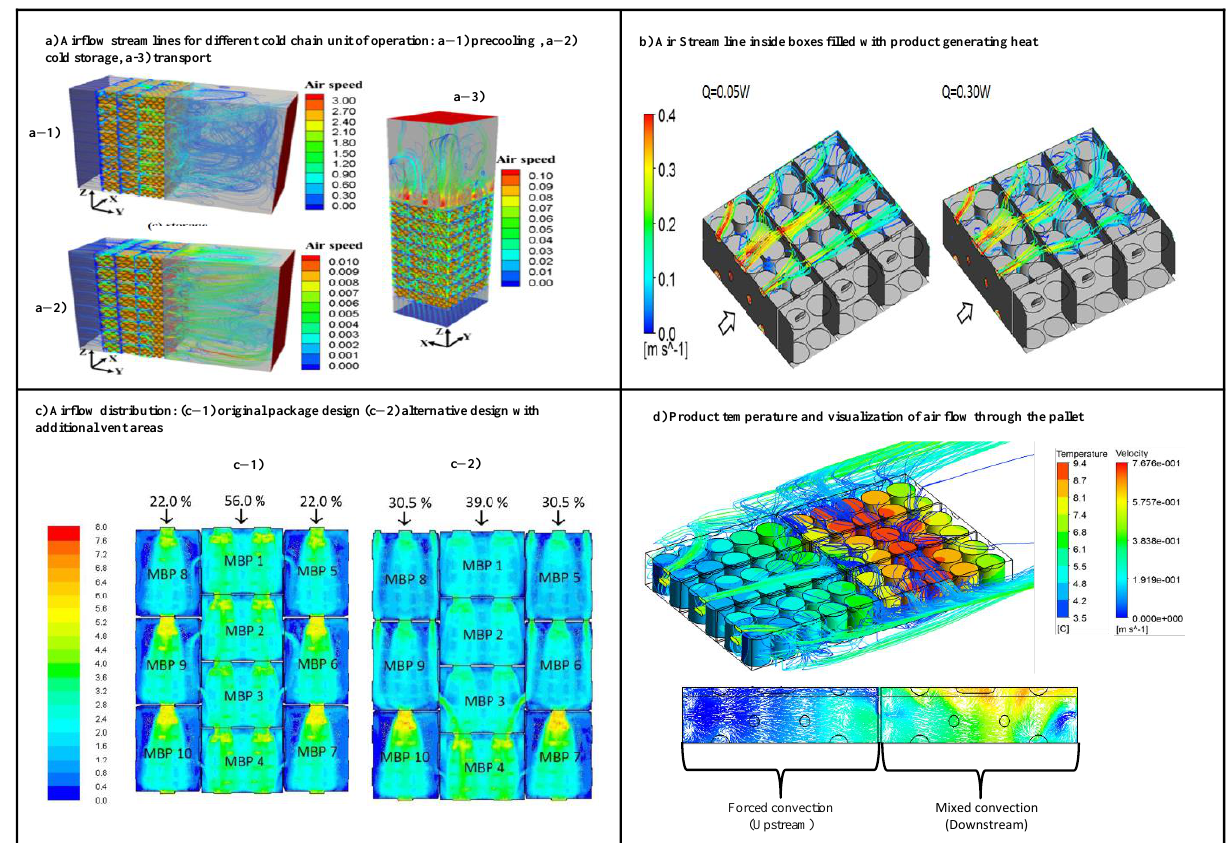
Figure 5. Airflow profiles inside different packaging designs: ( a ) [100], ( b ) [102], ( c ) [97], and ( d ) [103]. Cooling heterogeneity can be evaluated by local parameters like air velocity, product temperature, and CHTC. The latter parameter depends on air velocity, produce geometry, product orientation, packaging design, and other factors.